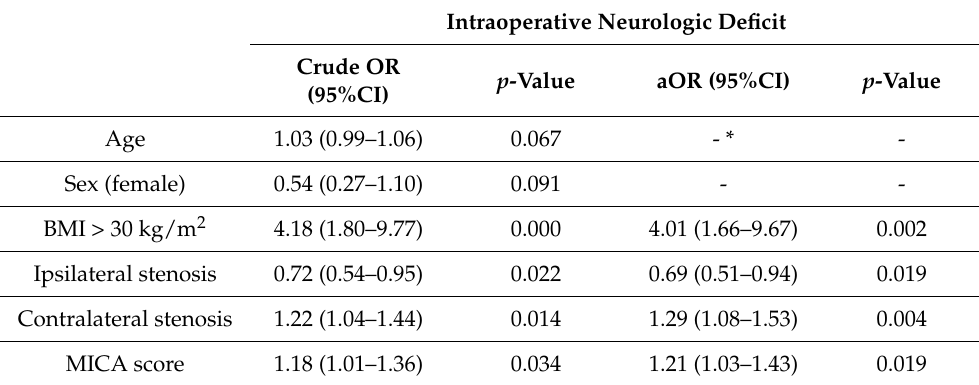
Table 2. Multivariable analysis by resorting to a regressive predictive model. Crude odds ratios (OR) and adjusted odds ratios (aOR) are displayed. The 95% confidence intervals (95% CIs) are